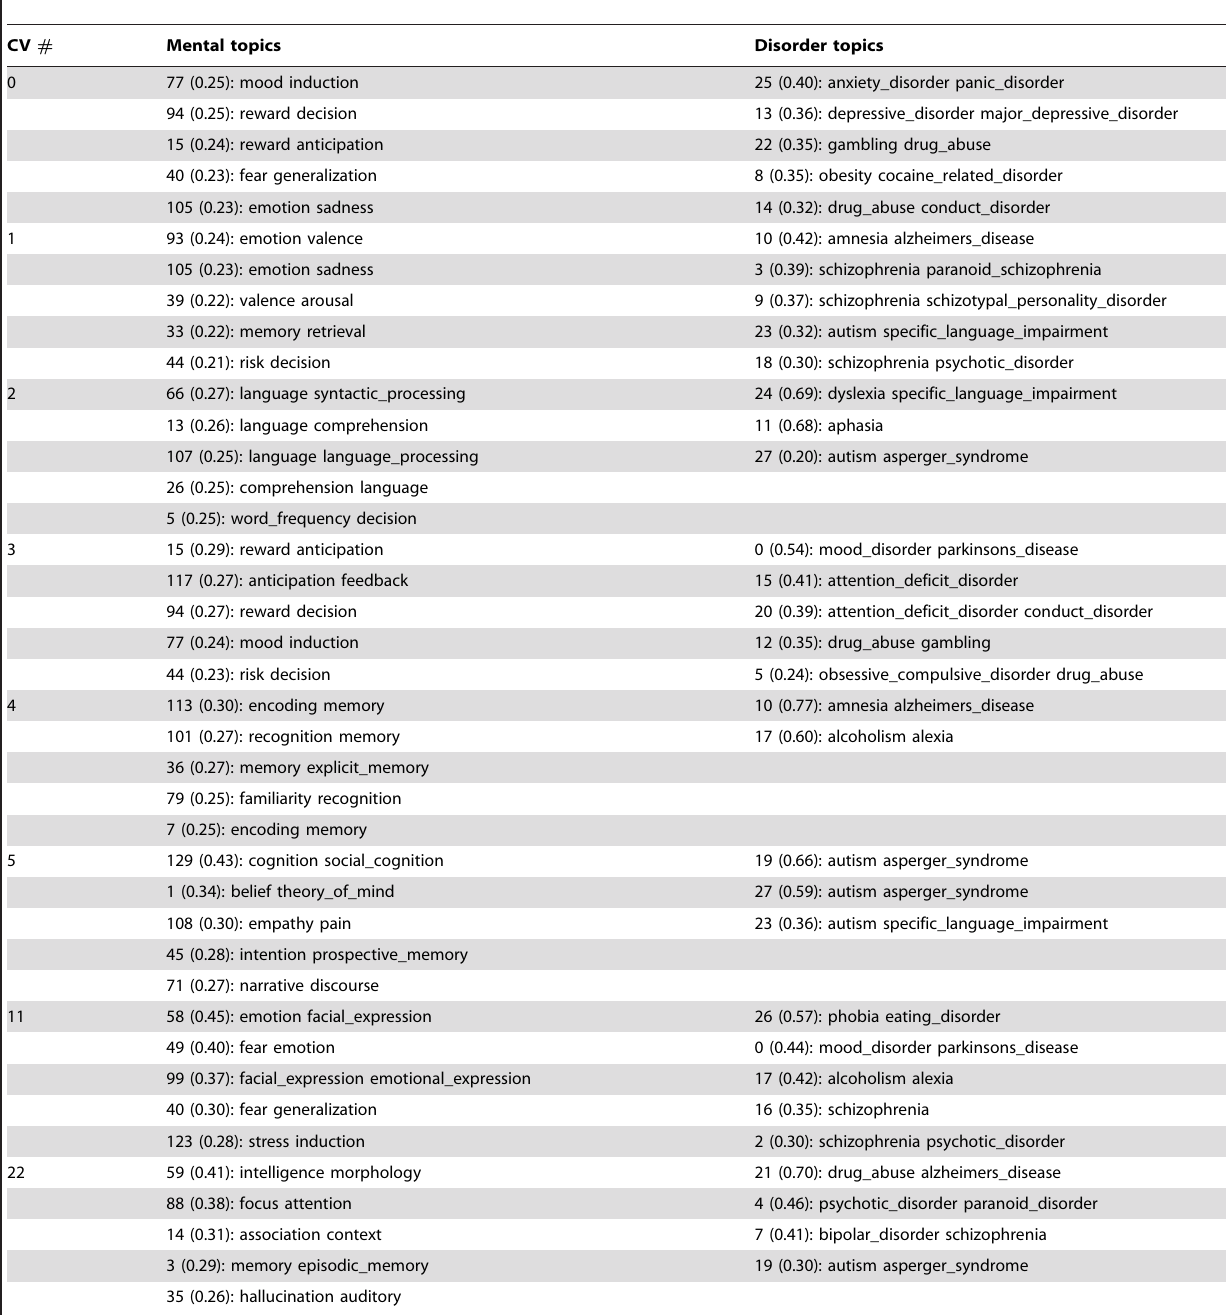
Table 1. Canonical variates obtained using sparse canonical correlation analysis on neural activation data for mental concept and disorder